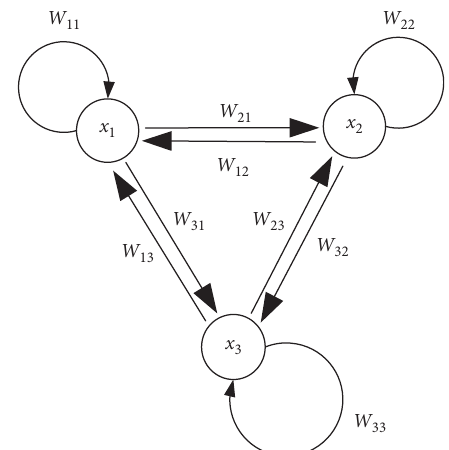
Figure 1: Connection of the neural network with three